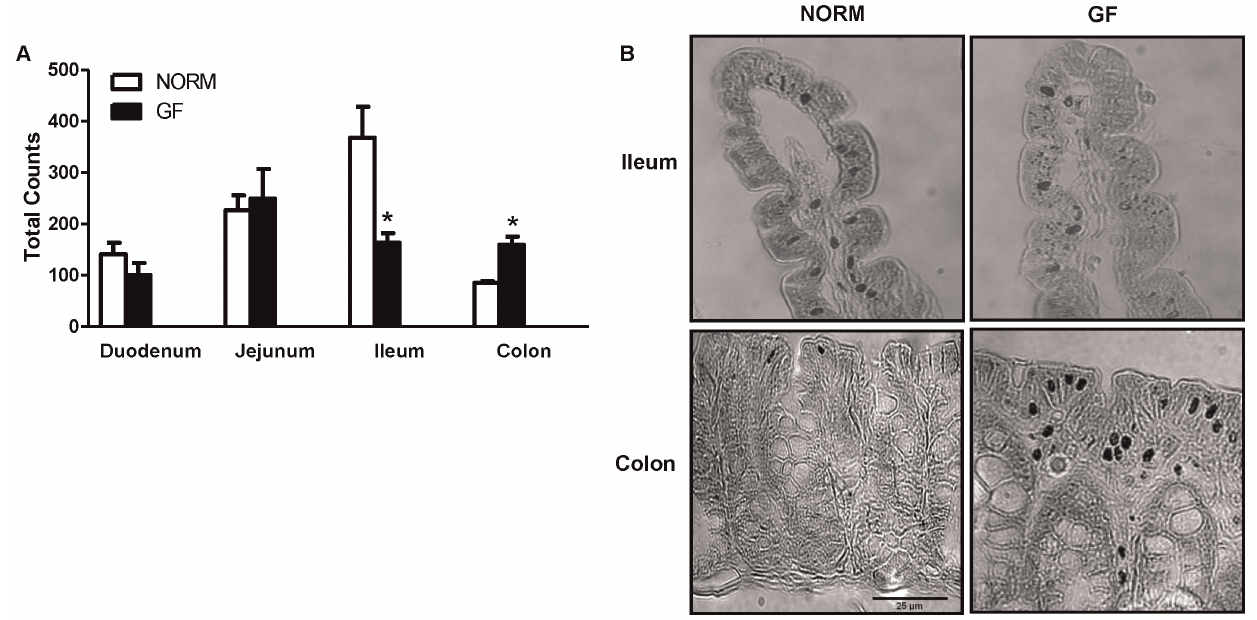
Figure 5. (A) Cell counts of enteroendocrine cells expressing chromogrannin-A and (B) representative microphotographs of ileum and colon sections at 100 6 magnification. GF mice had significantly less enteroendocrine cells in the ileum, but more in the colon, compared to NORM controls. Data are expressed as means 6 SEM. *P , 0.05, compared to NORM mice.